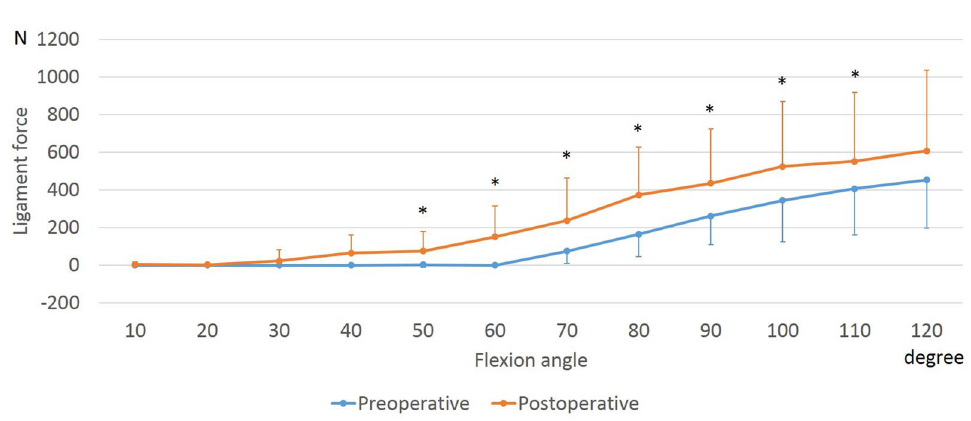
Figure 6. Force of the anterolateral bundle of the posterior cruciate ligament during squatting before and after unicompartmental knee arthroplasty. *Significant differences between preoperative and postoperative knees ( p ≤ 0.05).